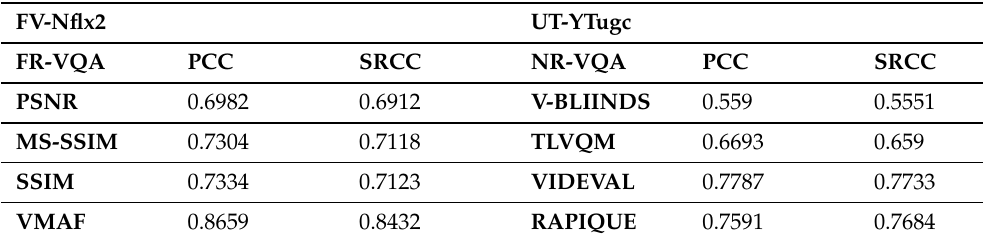
Table 2. Example performance of known VQAs in (a) the FR case by FastVDO, with no pretrained models; and in (b) the NR case, with UT-Google [10], using heavily trained models. While the FR case achieved useful levels of correlation with viewer ratings, the state of NR was more challenging. Recent advances have led to progress. Our FVQ achieved strong results in FR without pre-training; see Figure